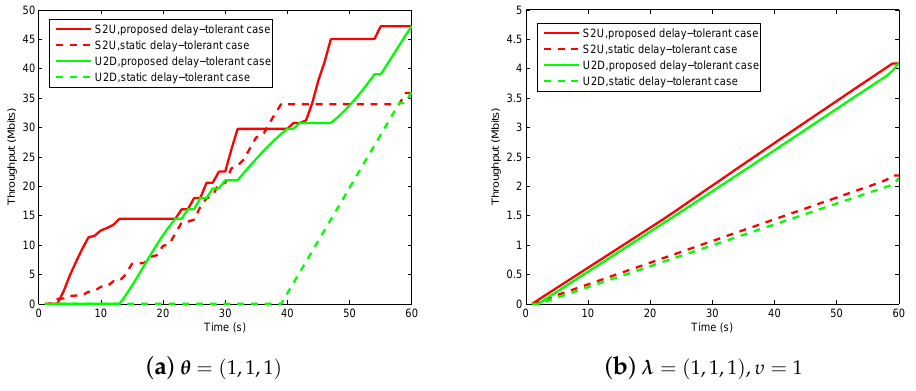
Figure 12. The information causality illustration for period T = 60